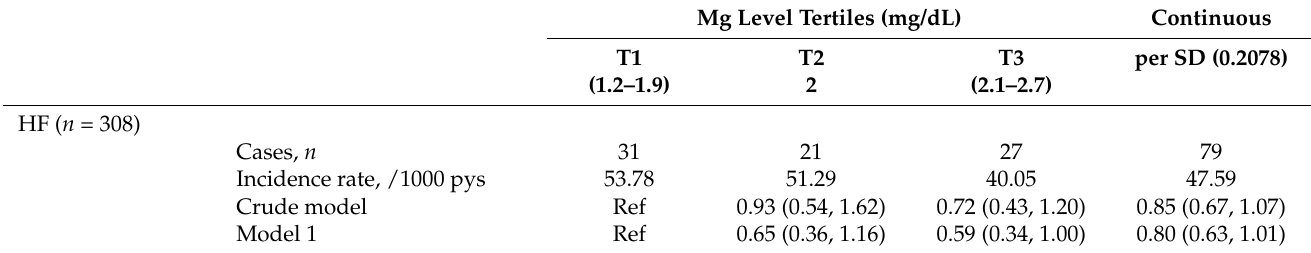
Table 2. Association between serum Mg and major adverse cardiovascular events among participants with prevalent atrial fibrillation, ARIC ( n =